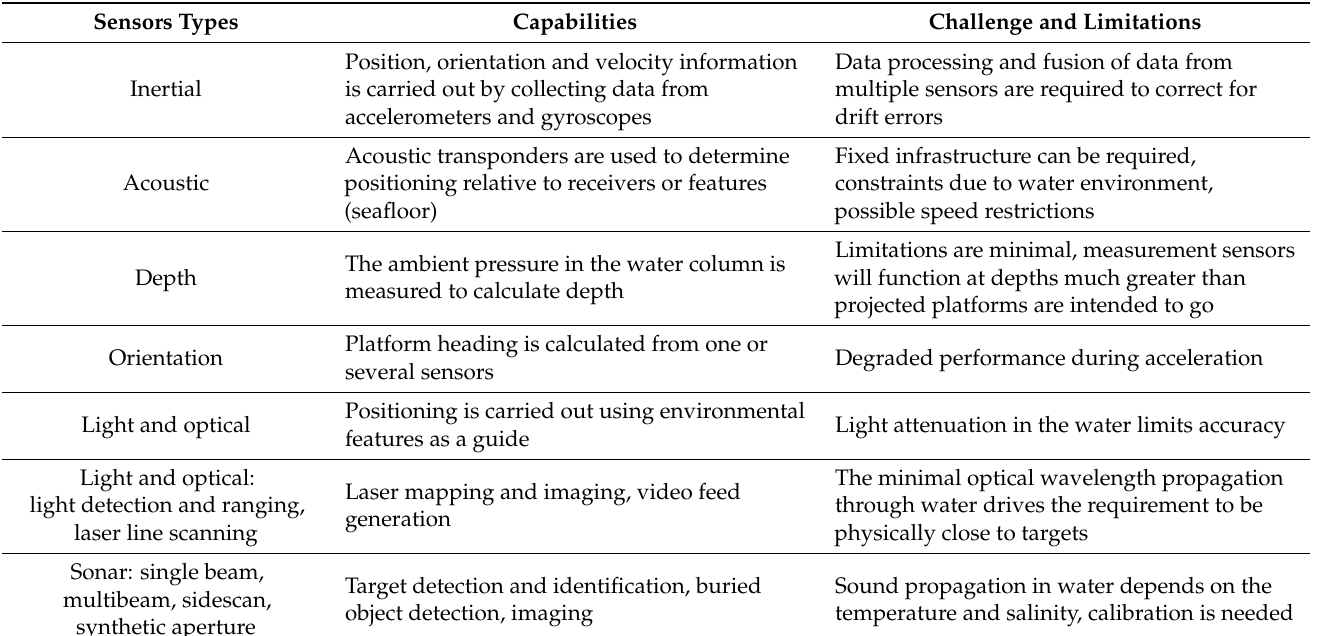
Table 7. Characteristics of UUV sensors